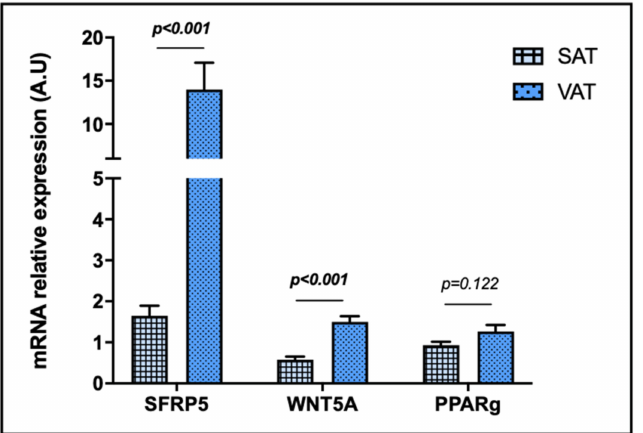
Figure 2. Differential relative mRNA abundance of SFRP5, WNT5A and PPAR γ in subcutaneous and visceral adipose tissue of the entire unclassified cohort. The data were normalized by NW group and expressed as mean standard error of the mean (SEM). SAT, subcutaneous adipose tissue; VAT, visceral adipose tissue; SFRP5, secreted frizzled-related protein 5; WNT5A, WNT family member 5a; PPAR γ , peroxisome proliferator-activated receptor gamma; A.U arbitrary units. p < 0.05 was considered statistically significant